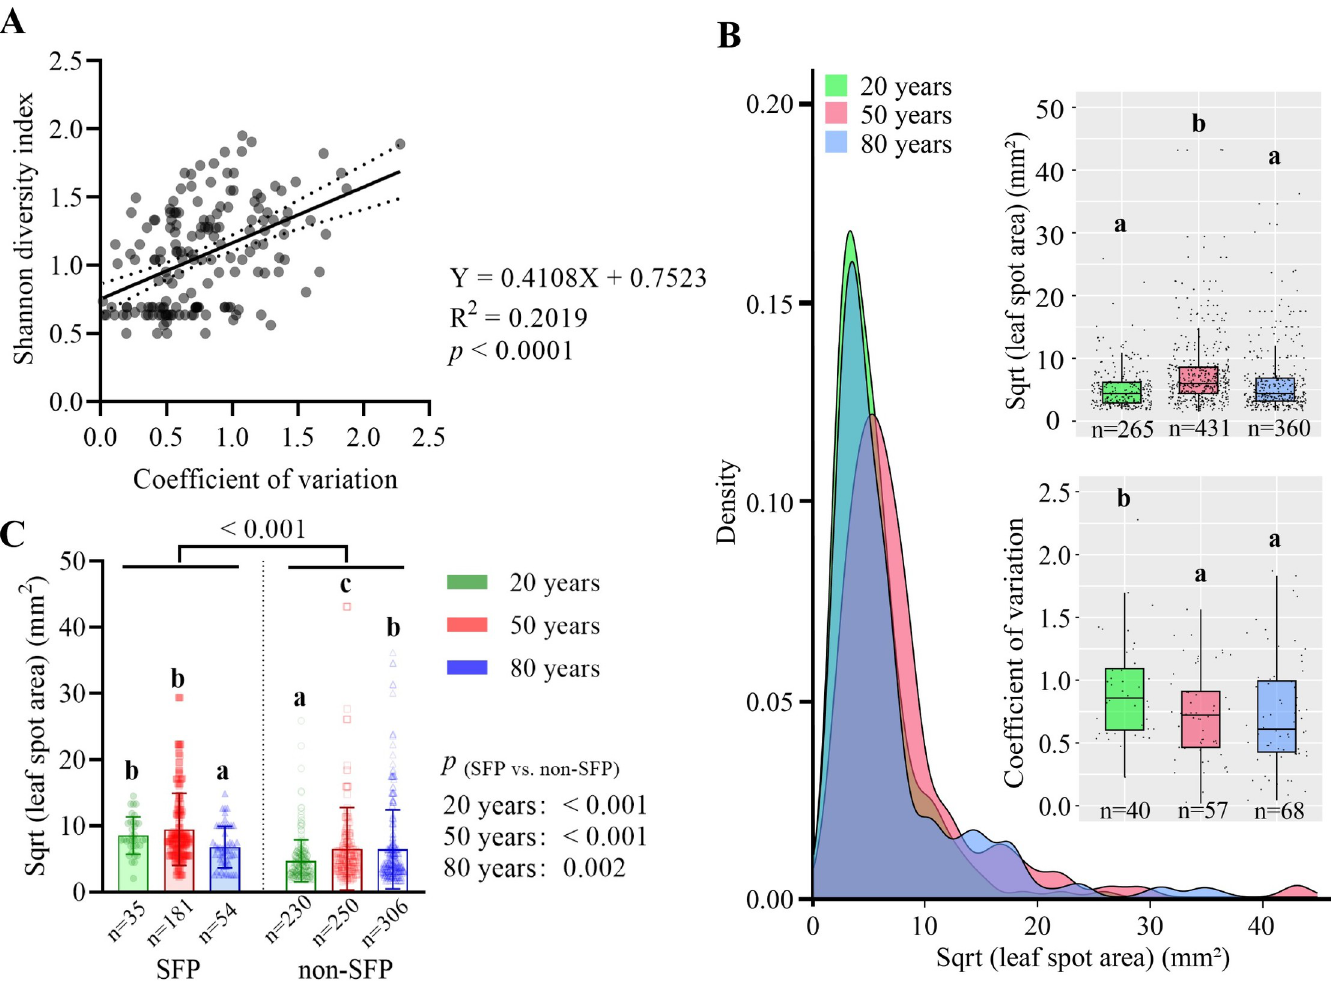
Fig 4. Fungal virulence evolution on the host A . adenophora . (A) Linear analysis of within-spot species diversity and virulence variations. Each spot represents a leaf spot with multiple infections (n = 165). (B) The density plots show the virulence distribution of fungal pathogens to A . adenophora at different invasion times. The boxplots show the differences in the average virulence (top) and the virulence variation (bottom) between different invasion times. (C) Virulence variation within spots of SFPs and non-SFPs at different invasion times. Nonparametric analysis with the Mann-Whitney U test was performed to test the significance of the differences, and different lowercase letters indicate significant differences ( p < 0.05). Differences between SFPs and non-SFPs at each invasion time are also given. The leaf spot area (mm 2 ) is shown as square root transformed. The error bar in panel (C) represents the standard